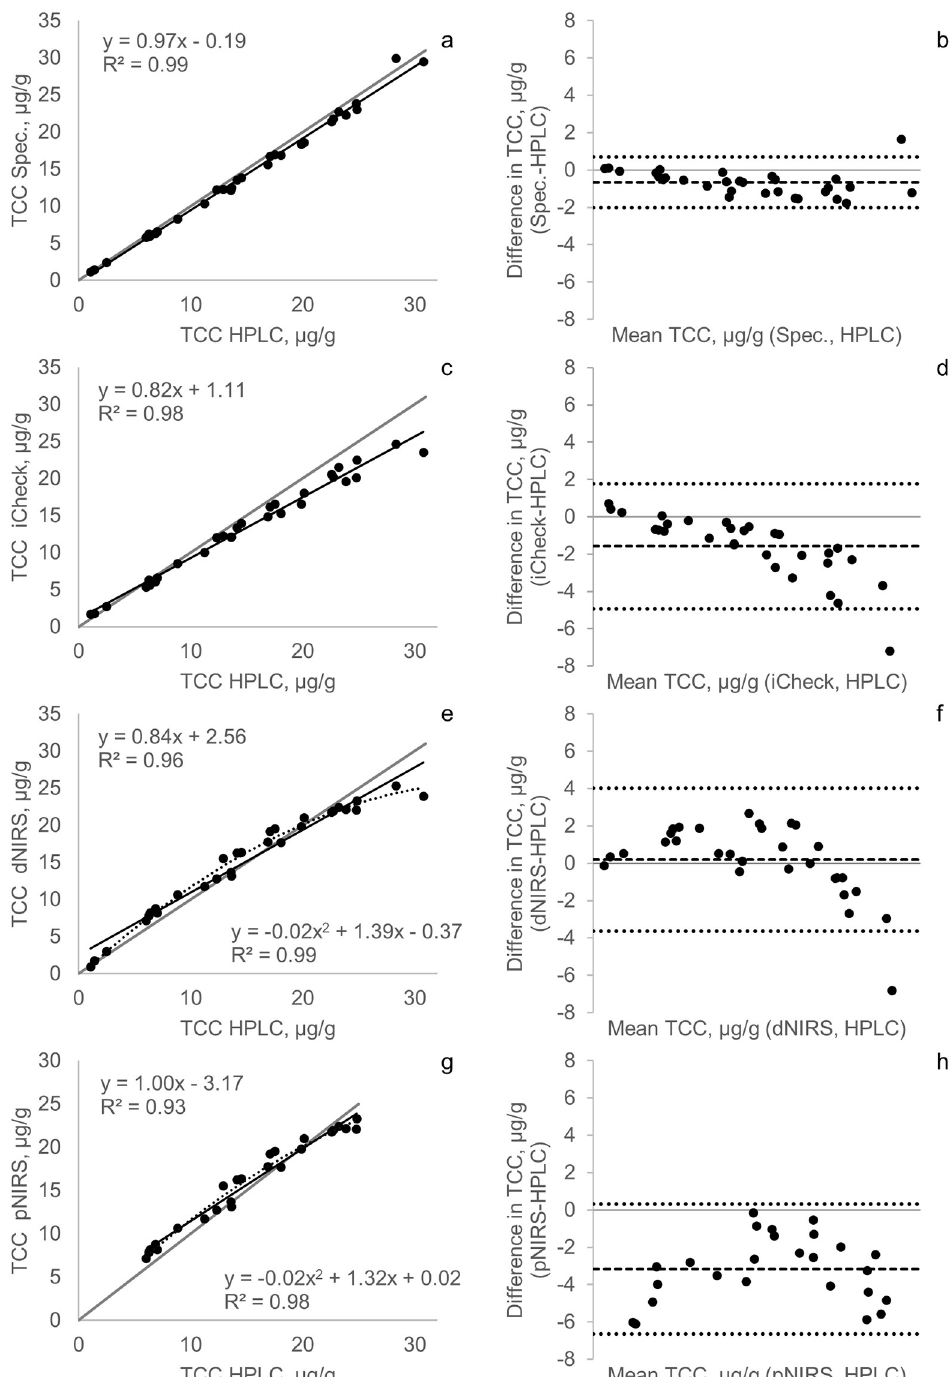
Fig 2. Scatterplots and Bland Altman comparison between TCC measured by HPLC versus spectrophotometer (a- b), iCheck Carotene (c-d), dNIRS (e-f), and pNIRS (g-h). The black lines indicate linear regression lines and the dotted lines indicate quadratic regression lines. Gray lines represent the line of identity. The square dotted lines represent the bias and the round dotted lines indicate the 95% confidence interval.